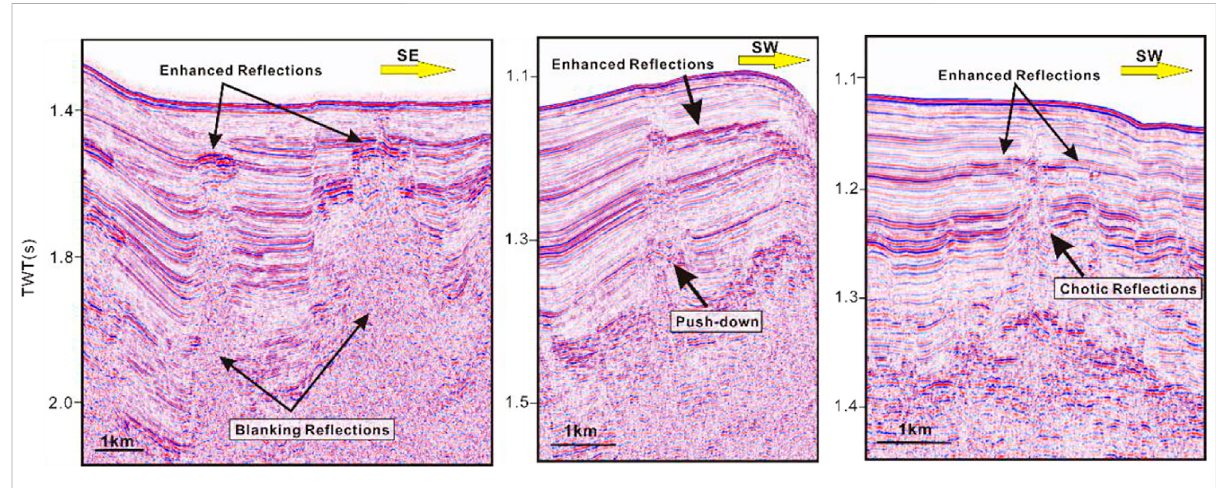
FIGURE 5 Seismicpro fi lesofthreetype-Bseismicchimneys.Thistypeofchimneyhasnosea fl oorexpressionssuchaspockmarksordomes.Seelocations in Figure